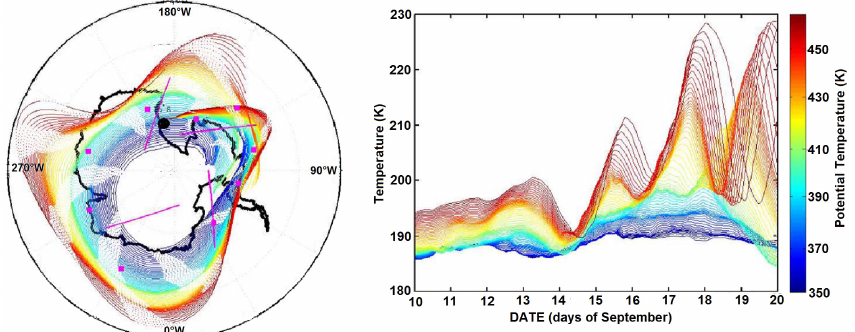
Figure 3. Left panel: air-mass trajectories originating from McMurdo (black dot) and run 10 days forward, color coded according to potential temperature. Solid colored lines indicate sunlit legs; dotted lines indicate legs in darkness. Purple lines specify intersections with the CALIOP footprint. Purple dots indicate where MLS data (O 3 , HNO 3 or HCl) were available. Right panel: temperature values along the trajectories, again color coded in terms of potential